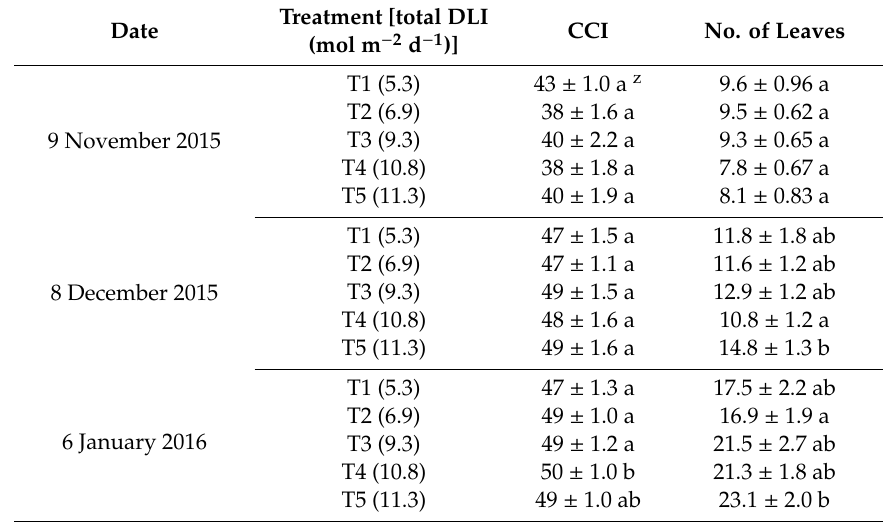
Table 2. Chlorophyll content index (CCI) of the youngest fully-expanded leaf, and number of leaves per plant, measured at ≈ 4-week intervals post-transplant of ‘Ultima’